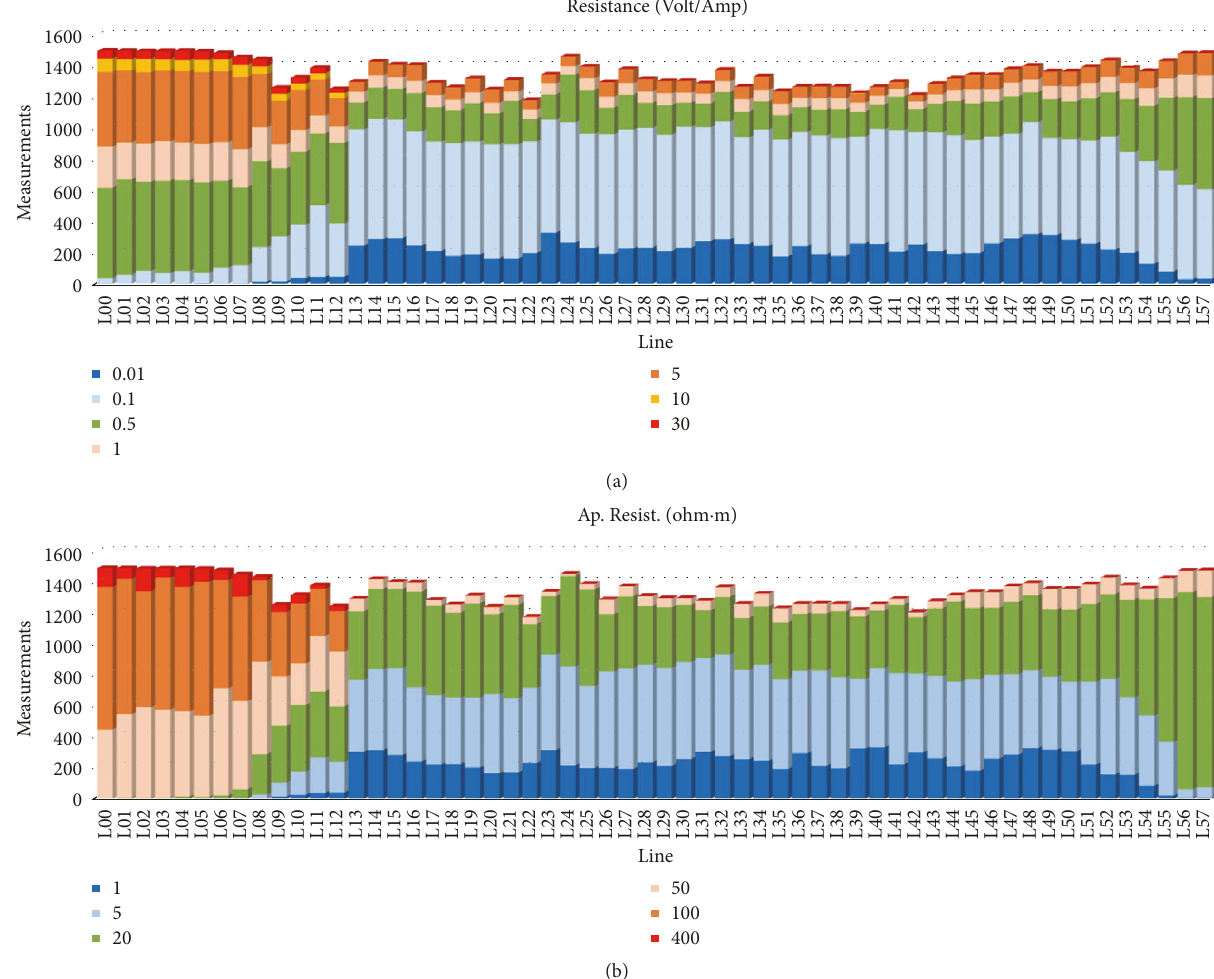
Figure 9: Histograms of resistance (a) and apparent resistivity (b) value per survey line.